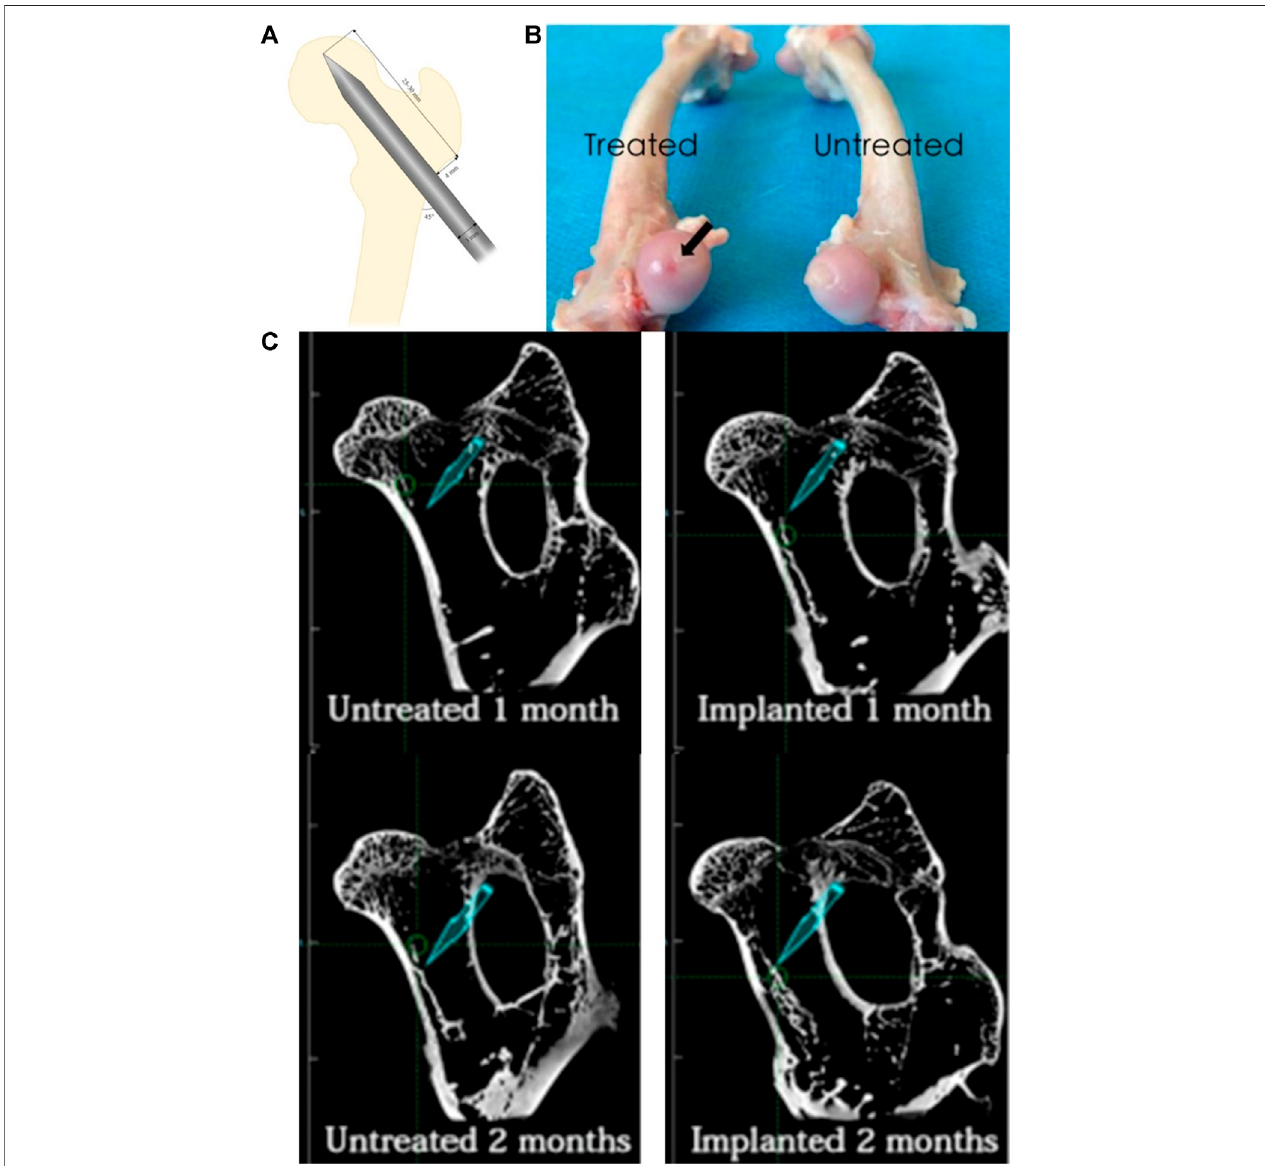
FIGURE 4 | HA-BP/CAP composite hydrogel can promote bone regeneration at the site of osteonecrosis (Wang et al., 2018). (A) The details regarding the standard animal model of ONFH. (B) The subchondral bone of the femoral head in the experimental group presented the establishment of the ONFH animal model because of the dark red area on the surface of the femoral head, while the untreated group appeared normal. (C) shows that the amount of bone regeneration at 1 and 2 months after injection of HA-BP/CAP composite hydrogel in the experimental group was signi fi cantly greater than that in the control group. Reproduced with permission (Wang et al., 2018). Copyright 2018, 2018 Elsevier